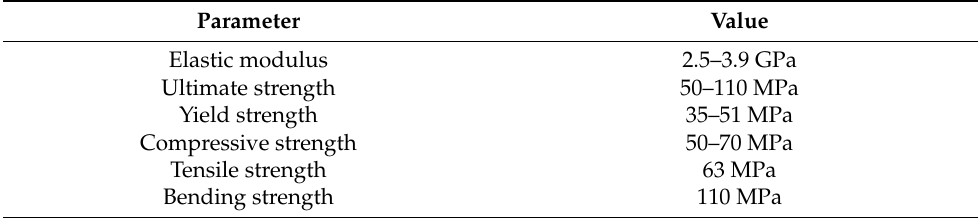
Table 3. Mechanical properties of trabecular Ta